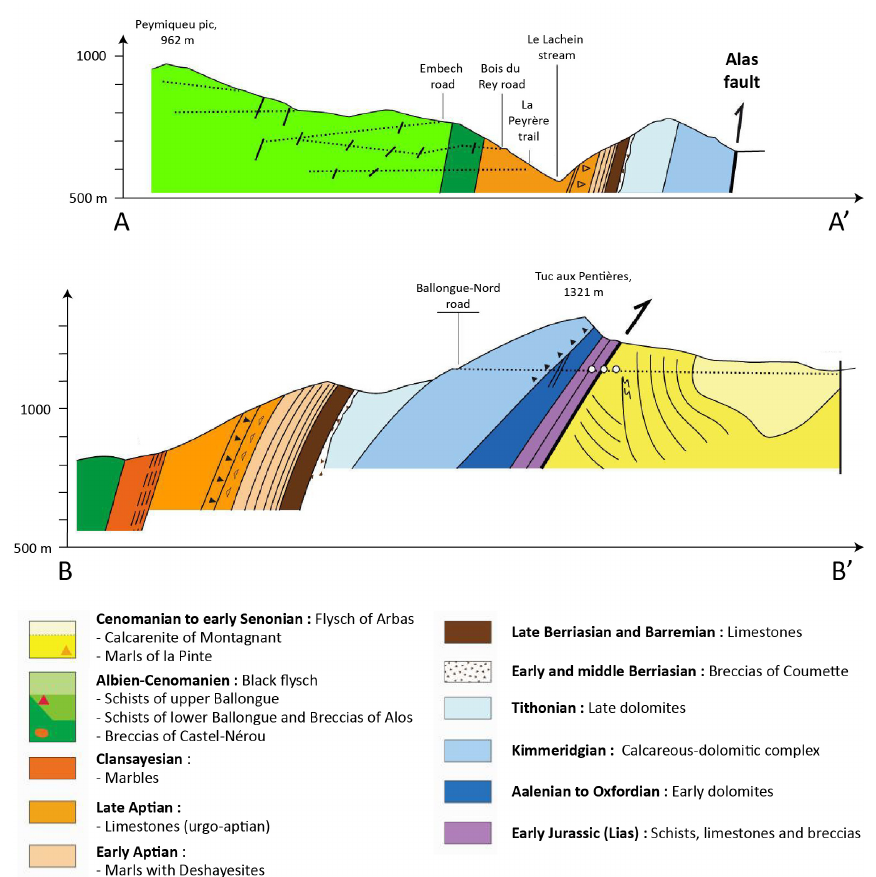
Figure A1. Geological profile sections of the Baget catchments (modified from Debroas [38]): ( A ) for downstream section A-A’ and ( B ) for upstream section B-B’. Line profiles are presented in Figure 1C.